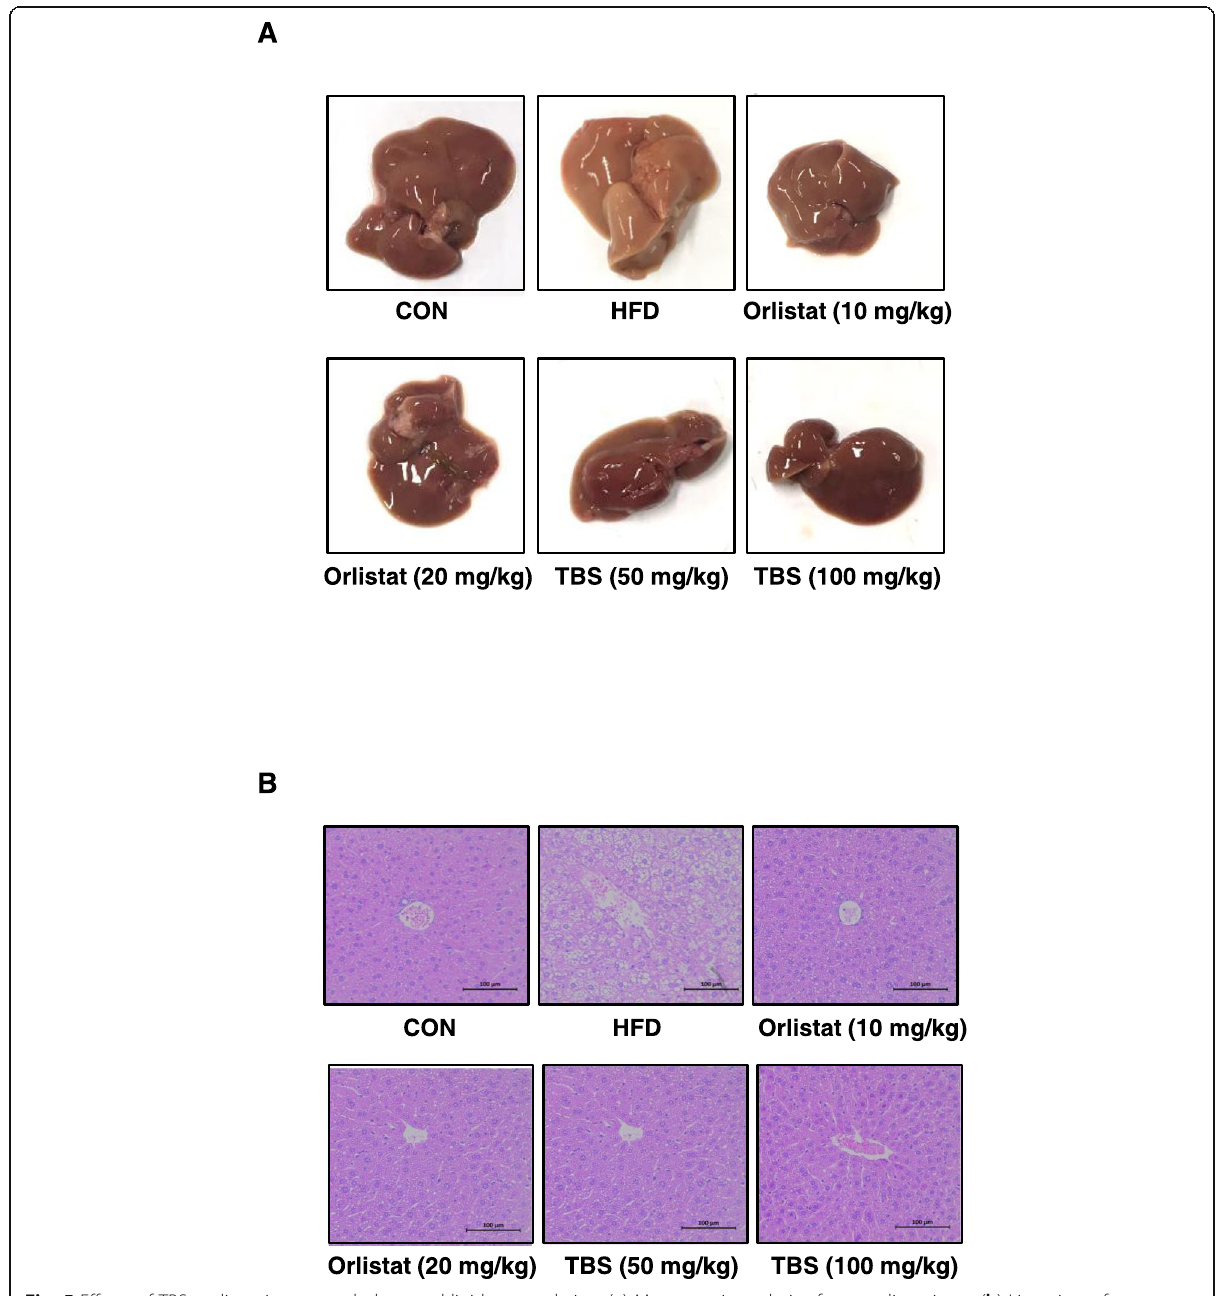
Fig. 5 Effects of TBS on liver tissue morphology and lipid accumulation. ( a ) Macroscopic analysis of mouse liver tissue. ( b ) Liver tissue from representative mice in each group were fixed, embedded in paraffin, and stained with H&E solution. Images are shown at the original magnification of 100x. CON: normal diet group; HFD: high-fat diet group; Orlistat: HFD plus orlistat (10 or 20 mg/kg) group; TBS: HFD plus TBS (50 or 100 mg/kg) group. Scale bar is 100 μ